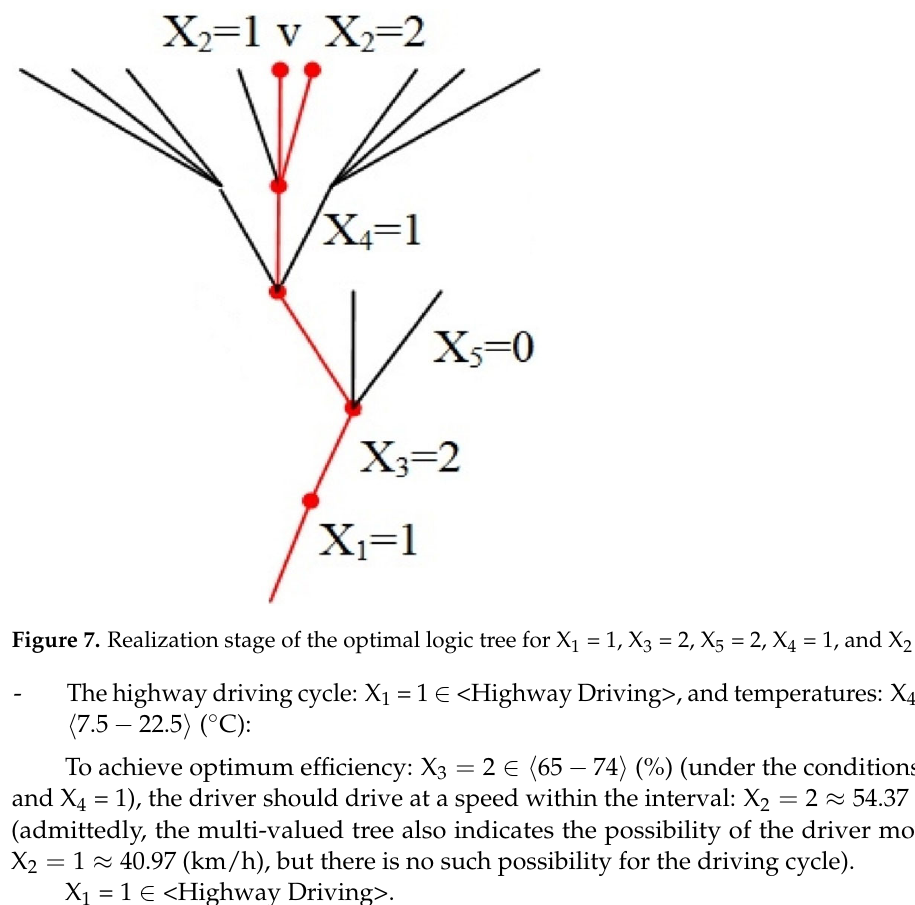
Figure 7. Realization stage of the optimal logic tree for X 1 = 1, X 3 = 2, X 5 = 2, X 4 = 1, and X 2 = 1, 2.